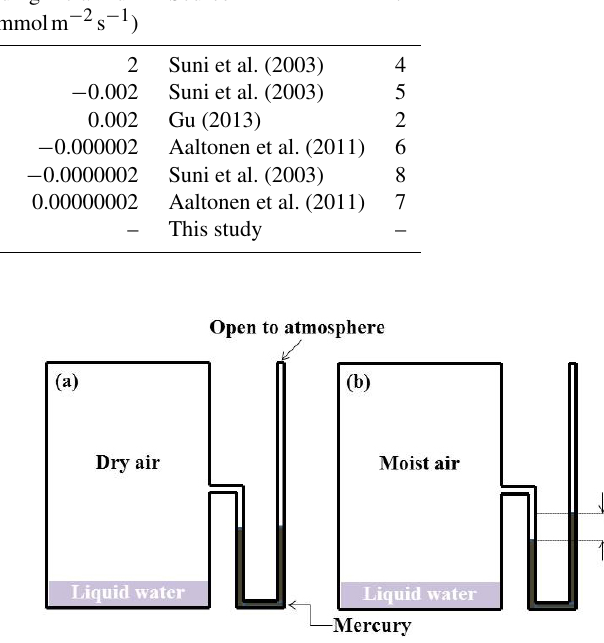
Figure 2. Illustration of evaporation incrementing air pressure. Chamber air evolves from (a) dry air initially at atmospheric pres- sure to (b) moist air at a pressure that has risen by the partial pres- sure of water vapour, ultimately at equilibrium (saturation vapour pressure, e s ). The force generated by evaporation propels the mer- cury in the manometer from its initial